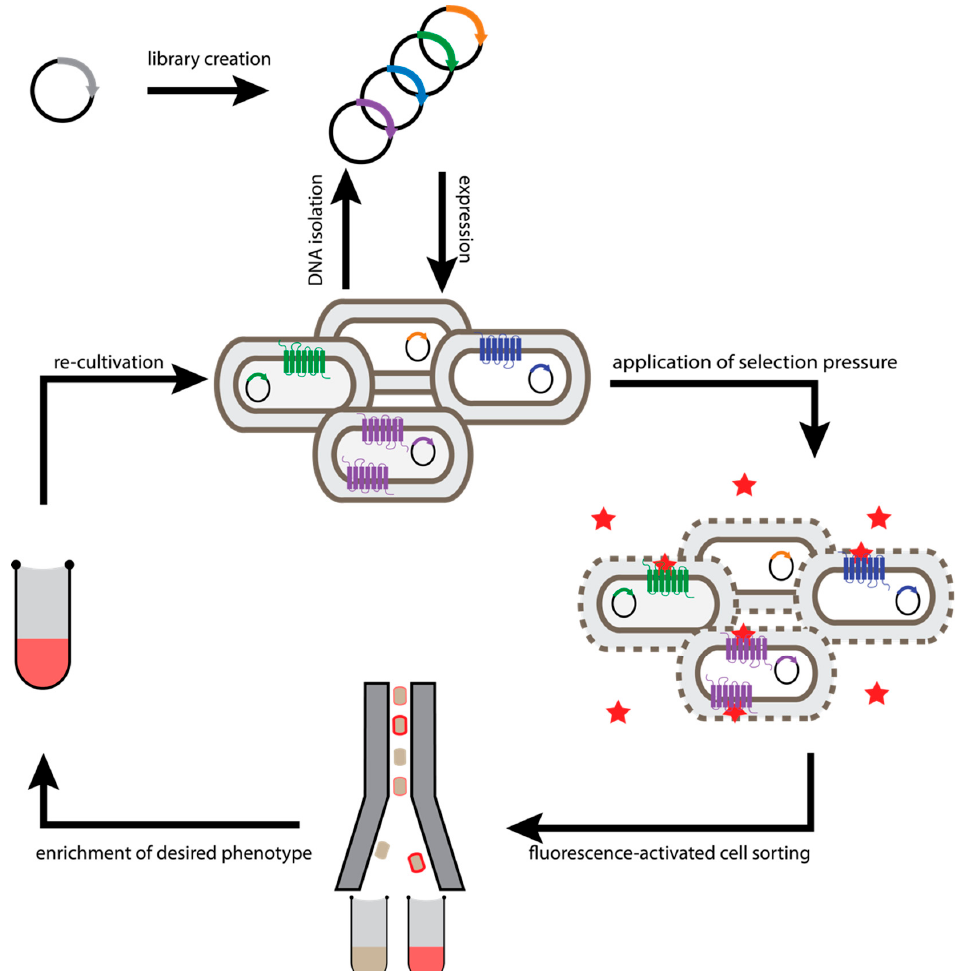
Figure 1. Workflow of E. coli -based selection methods. Evolution of GPCRs is initiated by diversification of the receptor gene. The resulting DNA library is used for transformation of E. coli cells, so that each cell takes up at most one plasmid molecule. Subsequently, one receptor variant is expressed in the inner membrane of a bacterial cell. To probe surface expression levels with a fluorescently labelled ligand (red star), the E. coli outer membrane is permeabilized (dashed oval). After incubation with fluorescently labelled ligand to bind to saturation, cell surface expression levels determine the number of bound ligands, and the cells exhibiting the highest fluorescence (i.e., cells with the highest GPCR expression) are enriched by fluorescence-activated cell sorting (FACS). Sorted cells are propagated in growth medium. Re-grown cell pools can either be subjected to additional rounds of selection or plasmids can be isolated for analysis of individual clones.